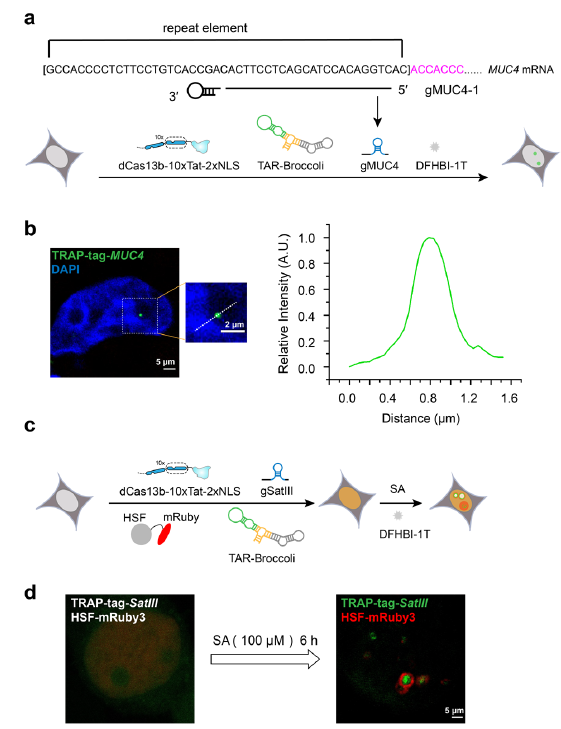
Figure 3. Tracking endogenous MUC4 mRNAs and long non-coding RNA SatIII via TRAP-tag. ( a ) Schematic of applying CRISPR-TRAP-tag to label MUC4 mRNAs. ( b ) Left, images of 293T cells co-transfected with pdPspCas13b-10 × Tat-2 × NLS, pgMUC4, and pTAR-Broccoli. The nucleus was dyed using DAPI and treated with DFHBI-1T (10 μ M); Right, relative fluorescence intensity of signal was scanned as the dotted line in the right panel. The diameter of the light point is about 0.5 μ m. Scale bar is shown in the figure. ( c ) Schematic of applying CRISPR-TRAP-tag to tracking SatIII lncRNA under SA treatment. ( d ) Images of the same cell before (left) and after (right) SA treatment; the cell is co-transfected with pHSF-mRuby3, pdPspCas13b-10 × Tat-2 × NLS, pgSatIII, and pTAR-Broccoli, and is treated with DFHBI-1T (10 μ M).